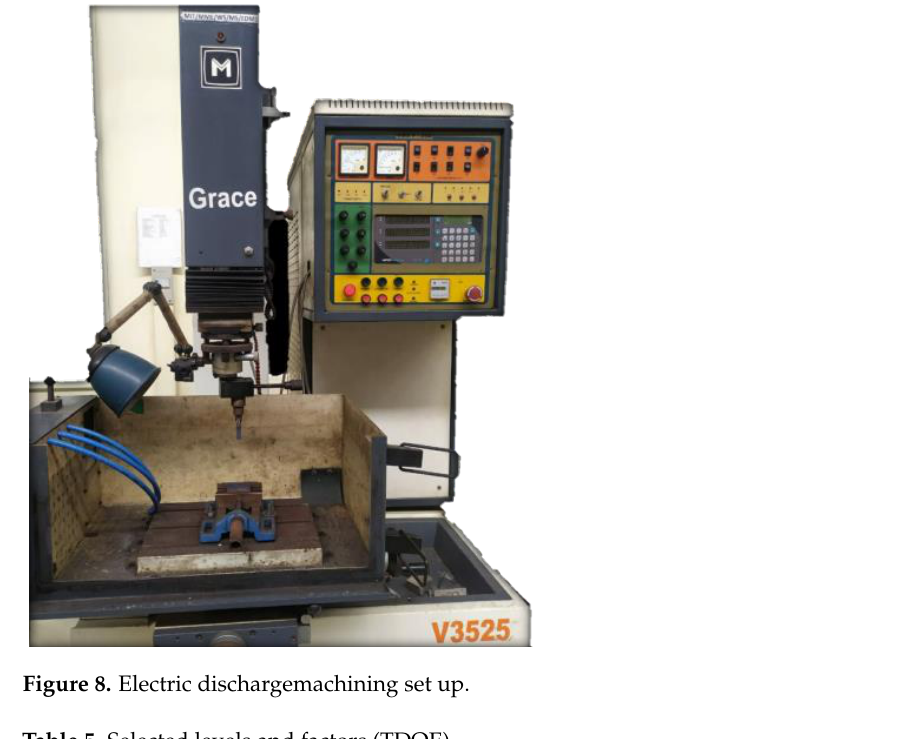
Figure 7. Electrodematerials:( a ) brass,( b ) copper, and( c ) graphite.